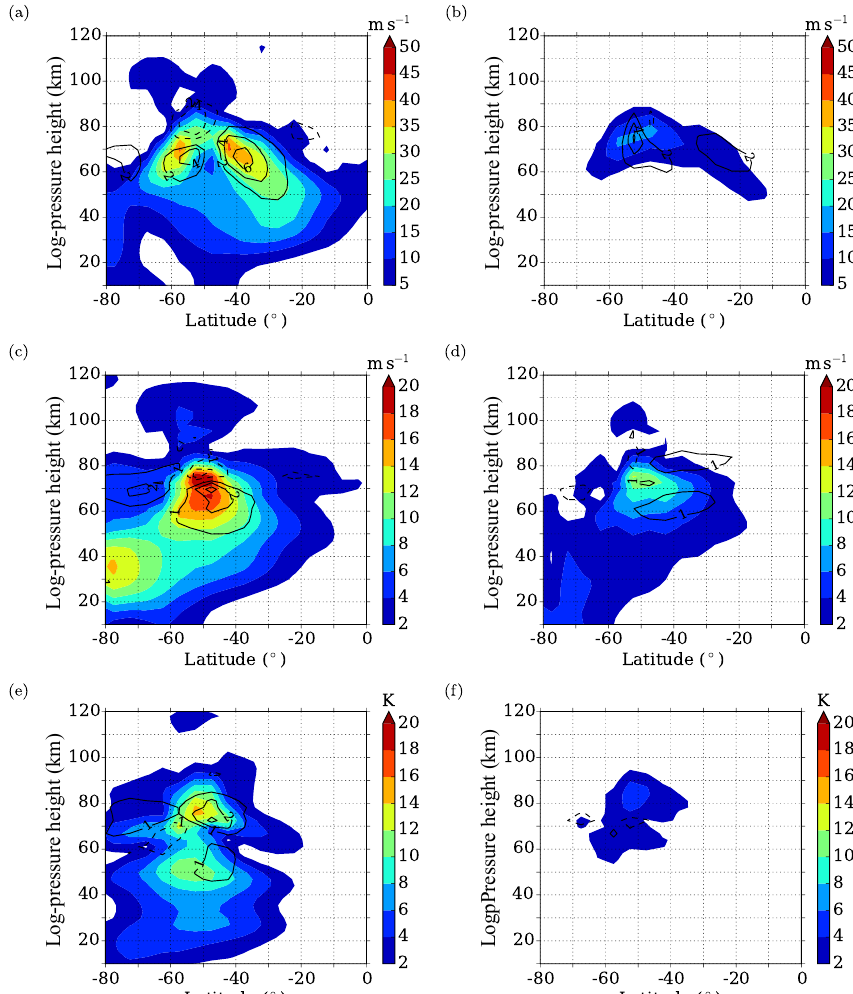
Figure 3. Run1: zonal wind (a, b) , meridional wind (c, d) and temperature (e, f) amplitudes of SPW1 (left column: a, c, e ) and SPW2 (right column: b, d, f ) as background colors. Run2–Run1 differences are added as isolines in steps of 2ms − 1 (zonal wind), 1ms − 1 (meridional wind) and 1K